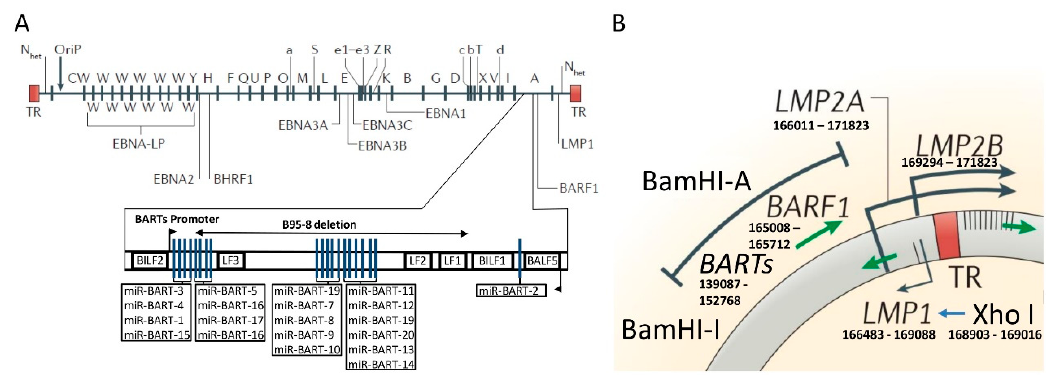
Figure 1. Genomic map of Epstein-Barr virus (EBV) genome with major phylogeographic variants. ( A ) Diagram shows the location of open reading frames for EBV latent proteins on the BamHI restriction map of the prototype EBV B95-8 genome. The BamHI fragments are named according to size and are indicated by capital letters, with A being the largest. Lowercase letters indicate variations in size within these fragments. TR refers to the terminal repeats at each end of the genome. Below is a schematic representation of viral miR-BARTs in sequence order with deletion indicated within the BamHI-A fragment of the EBV genome in the B95-8 strain. N het is used to indicate heterogeneity in this region according to the number of TRs within different virus isolates. ( B ) Schematic representation of the genomic location of BamHI-I and BamHI-A fragments with TR. Within the exon 1 of LMP1 gene is the XhoI restriction site. The region containing the BamHI-I and XhoI restriction site is 21,277 nucleotides long and contains several relevant transcripts (miR-BARTS and BARF -1) for EBV transformation abilities. Figure is adapted from References [39] (with permission to use part of the figure) and [40] (localization of miR-BARTs).